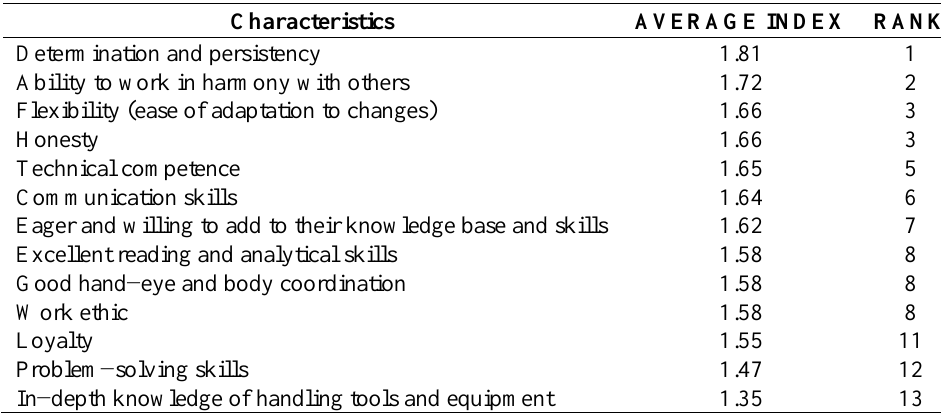
Table 6. Skilled Labour